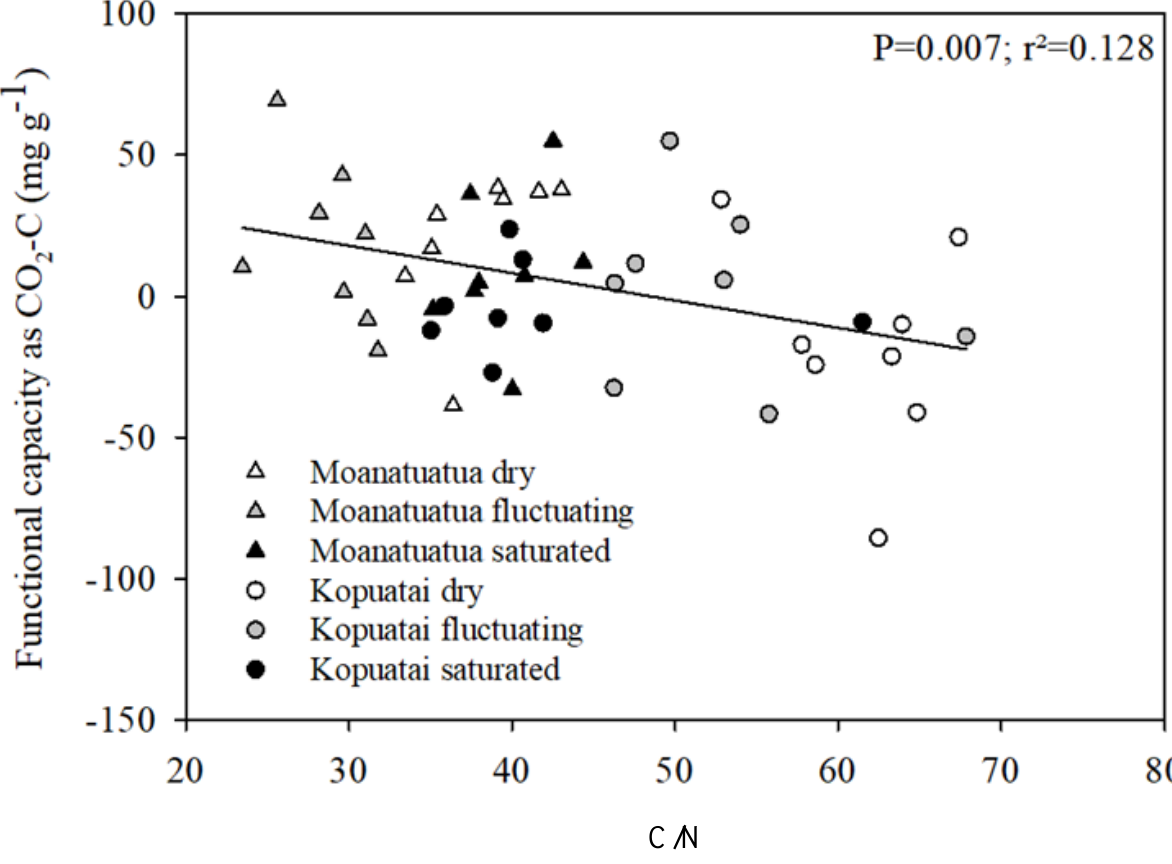
Figure 4. Linear regression analysis of functional capacity and C/N at the Kopuatai (grey circles) and Moanatuatua (black circles)